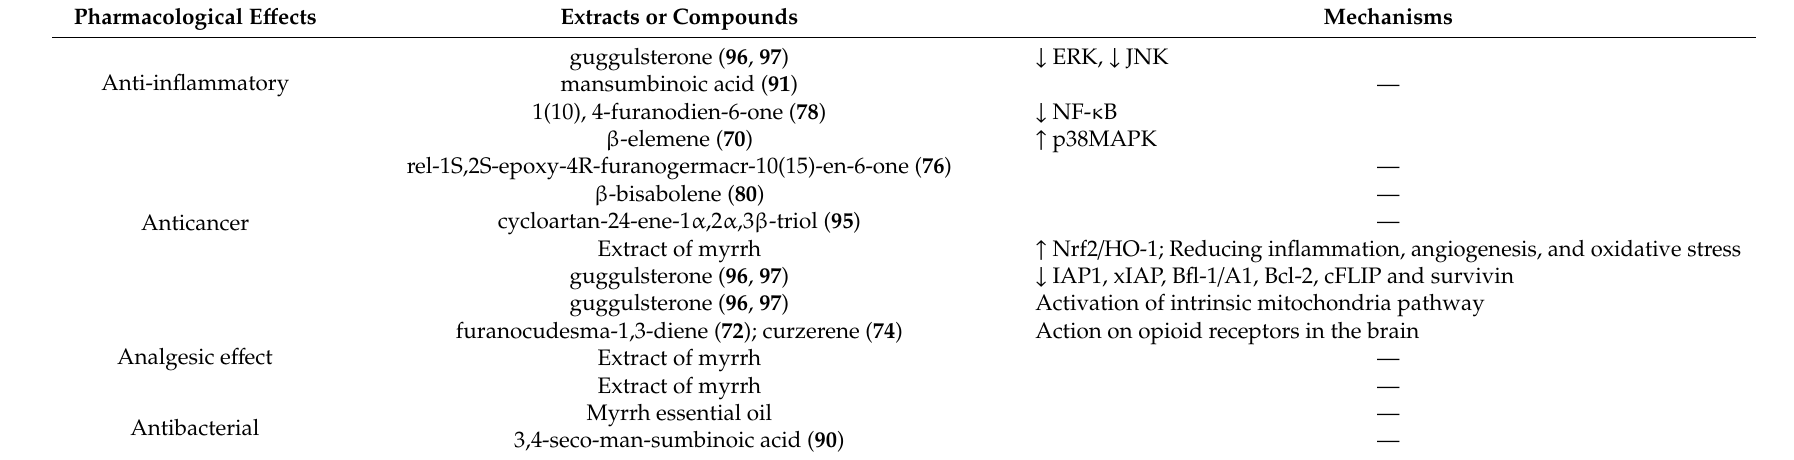
Table 4. Pharmacological e ff ects and mechanisms of